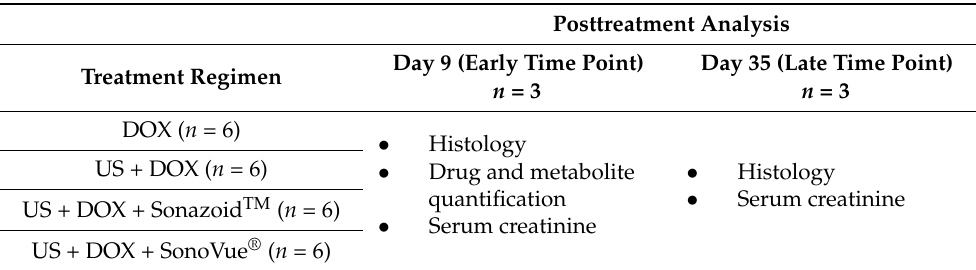
Table 1. Experimental groups and posttreatment evaluation techniques and time points. DOX = Doxorubicin; US =